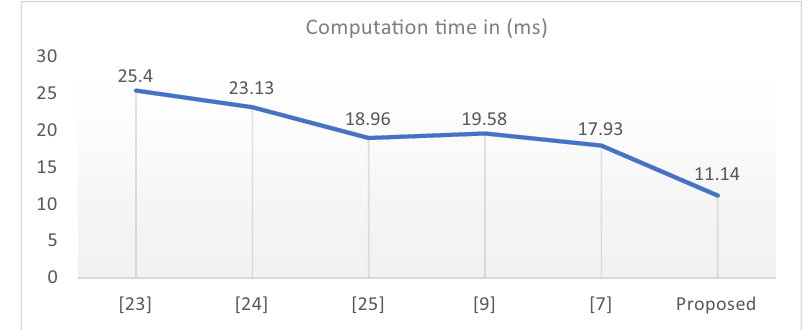
Figure 4: Comparison of computation